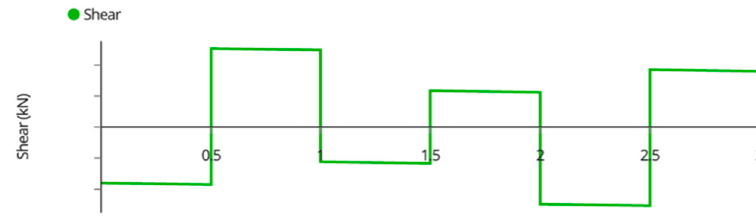
Figure A10. Beam shear force